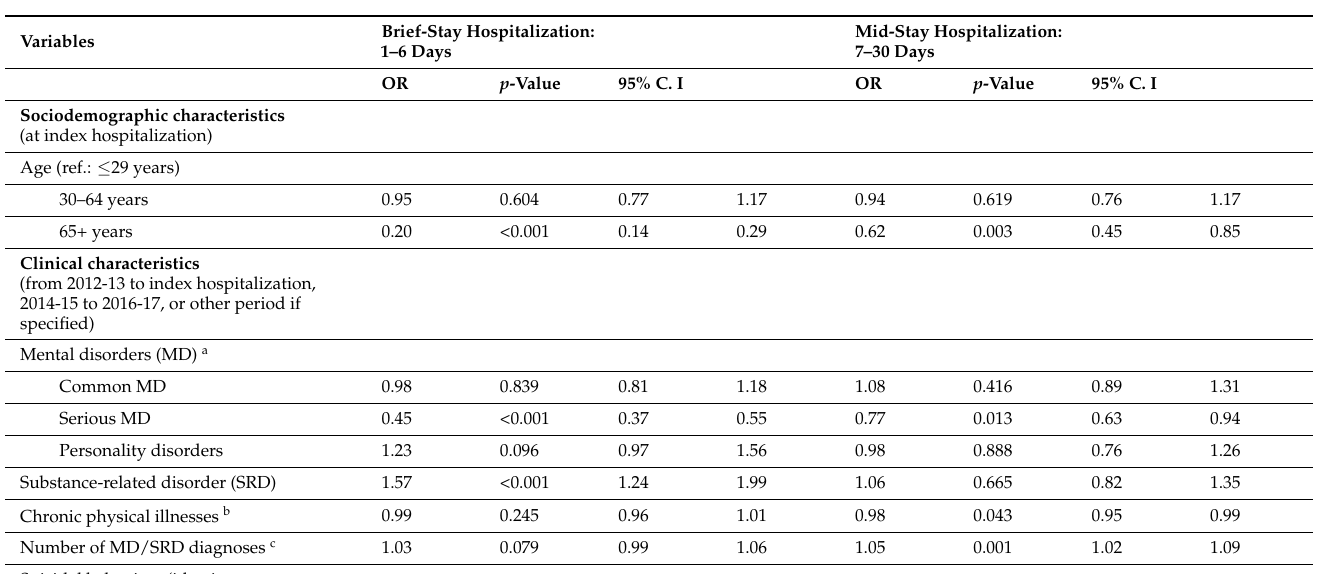
Table 3. Multivariate multinomial logistic regression model on index hospitalization for